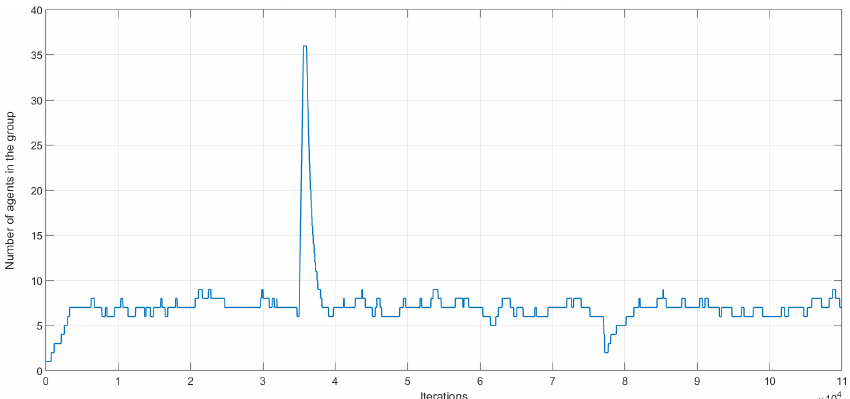
Figure 13. Adaptation of the group’s population in a space of 10 × 8 × 5 cells, simulated for 25,000 iterations, Pmax { f , k , v } = Pa { f , k , v } = Pr { f , k , v } = 200, TCa { f , k , v } = 0, TRa { f , k , v } = 100,